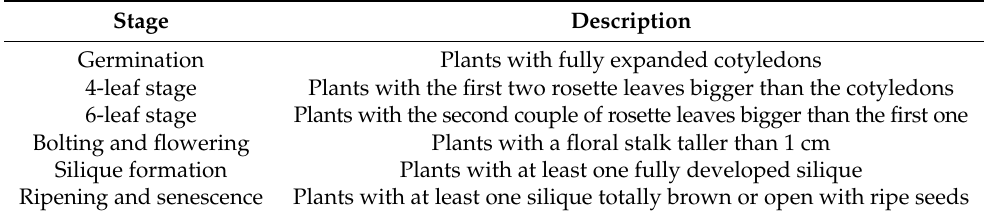
Table 1. A. thaliana growth stages recorded in this work. Stage Description Germination Plants with fully expanded cotyledons 4-leaf stage Plants with the first two rosette leaves bigger than the cotyledons 6-leaf stage Bolting and flowering Silique